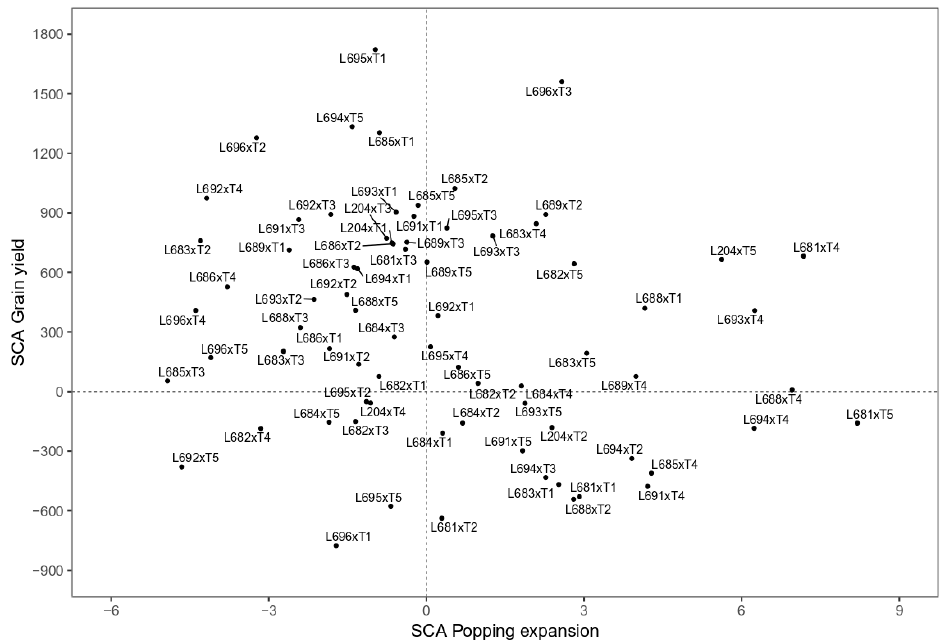
Figure 2. Scatter plot of estimates of specific combining ability (SCA) effects associated with 75 hybrids from testcross for grain yield (GY) and popping expansion (PE) traits. The T terms refer to the testers, these being T1 = PARA 172; T2 = L270; T3 = L651; T4 = P1; and T5 = L70. For GY, it was possible to identify 52 hybrid combinations with positive SCA values (Figure 2) ranging from 9.32 to 1722.87. The six hybrid combinations that exhibited the highest estimates for this trait were L695 × PARA 172, L696 × L651, L694 × L70, L685 × PARA 172, L696 × L270, and L685 × L270. Considering PE, 35 combinations expressed